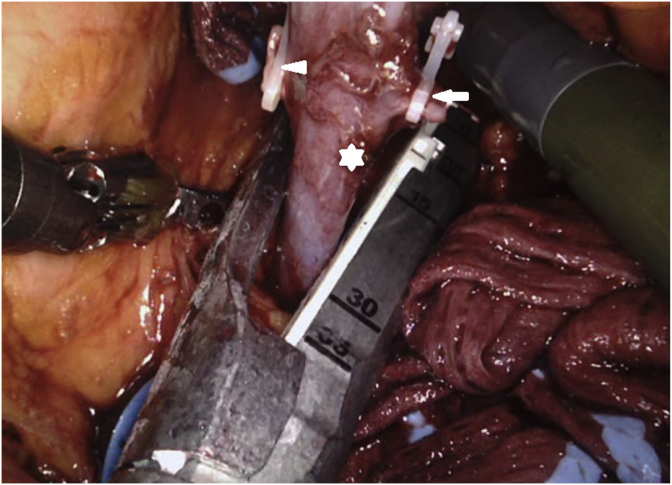
Transection of the left renal vein using 35 mm Endo GIA stapler (renal vein; white star, gonadal vein; white arrow, adrenal vein; white arrowhead).